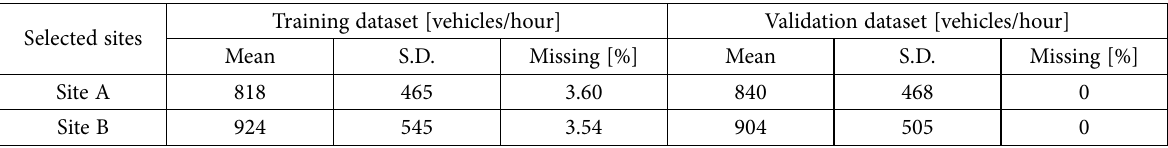
Table 1. Descriptive Statistics of traffic data used in Scenario 1